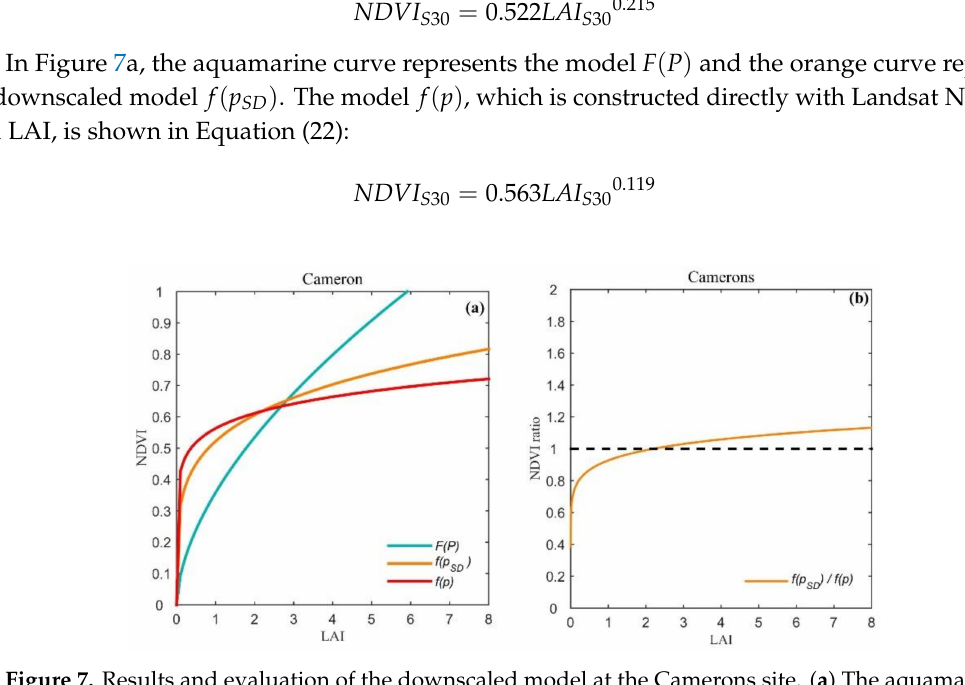
Figure 7. Results and evaluation of the downscaled model at the Camerons site. ( a ) The aquamarine curve is the model F ( P ) at 1 km spatial resolution established by the OLS method; the orange curve is the downscaled model f ( p SD ) established by SEMPs; the red curve is the model f ( p ) at 30 m spatial resolution directly established by the OLS method; ( b ) the orange curve is the NDVI ratio between f ( p SD ) and f ( p )